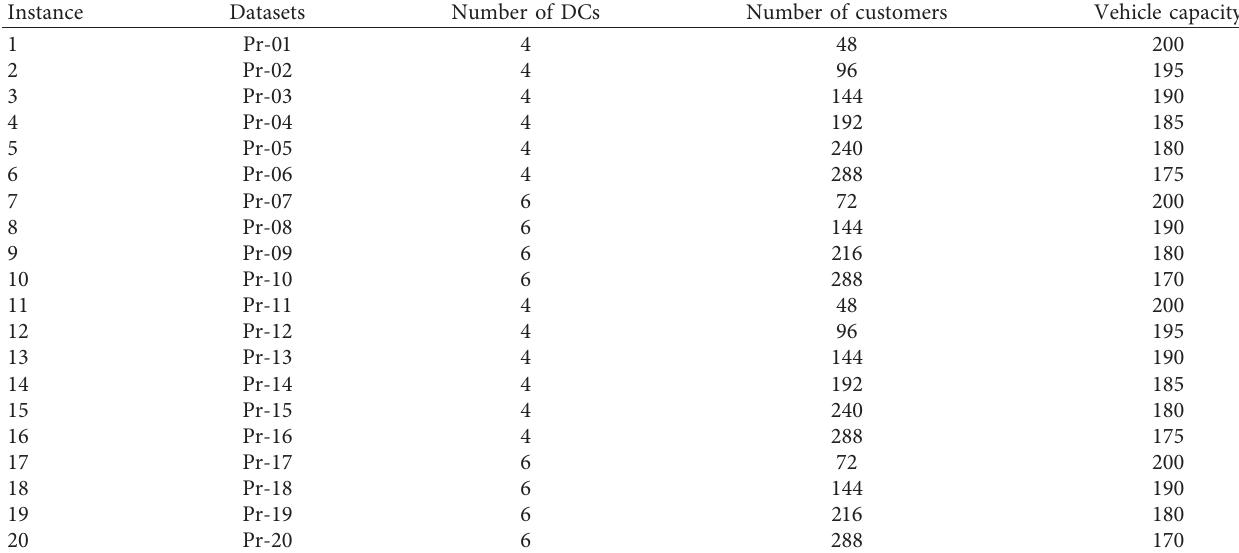
Table 9: Description of instances.